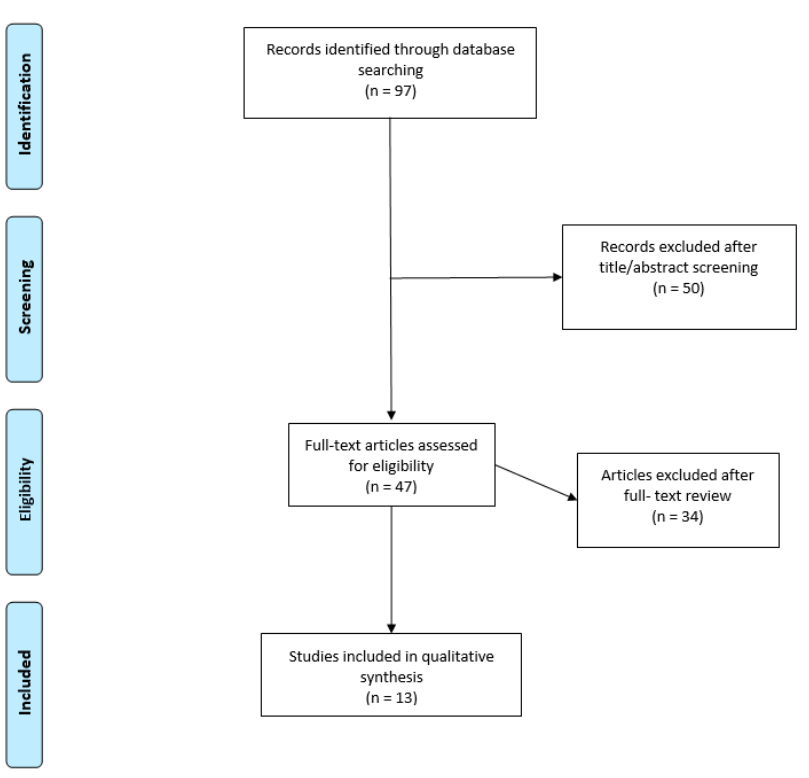
Figure 1. Visualization of study selection. Flow diagram showing process of study selection.